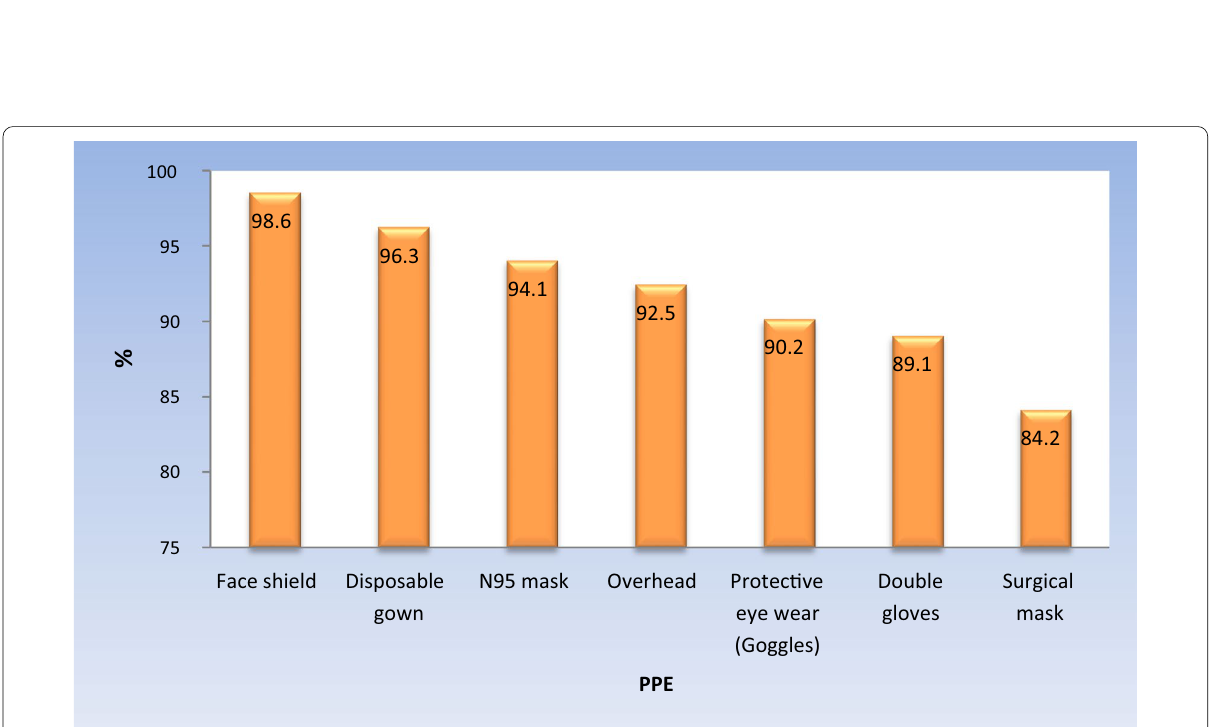
Fig. 3 Bar chart representing distribution of important personal protective equipment